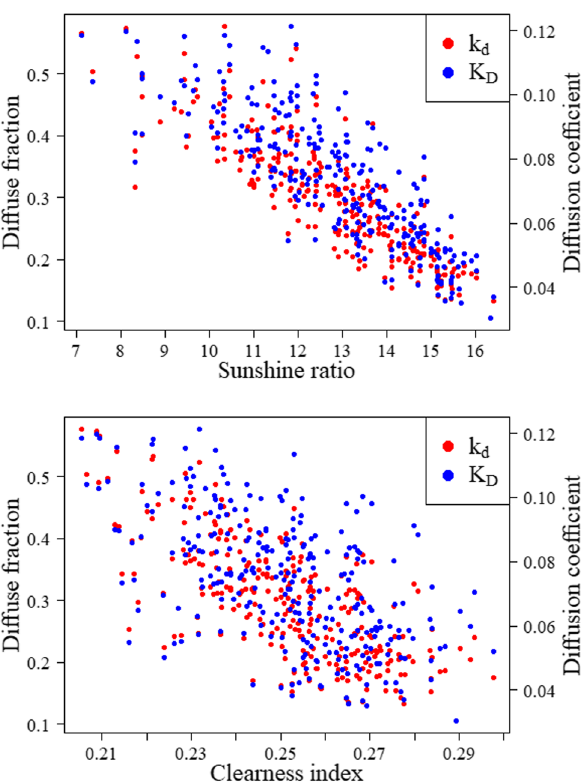
Fig. 3 Scatter plots for diffuse fraction ( k ( K D ) with sunshine ratio (in the top) and clearness index (in the bot-